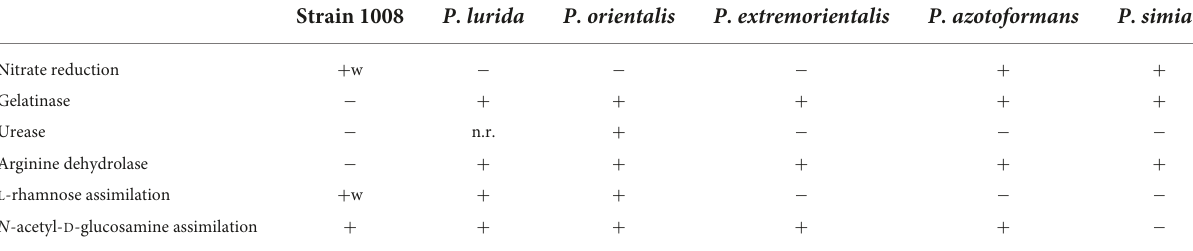
TABLE 6 Biochemical features differentiating Pseudomonas sp. strain 1008 from the type strains of closely related species (see Table 4 and Figure 4